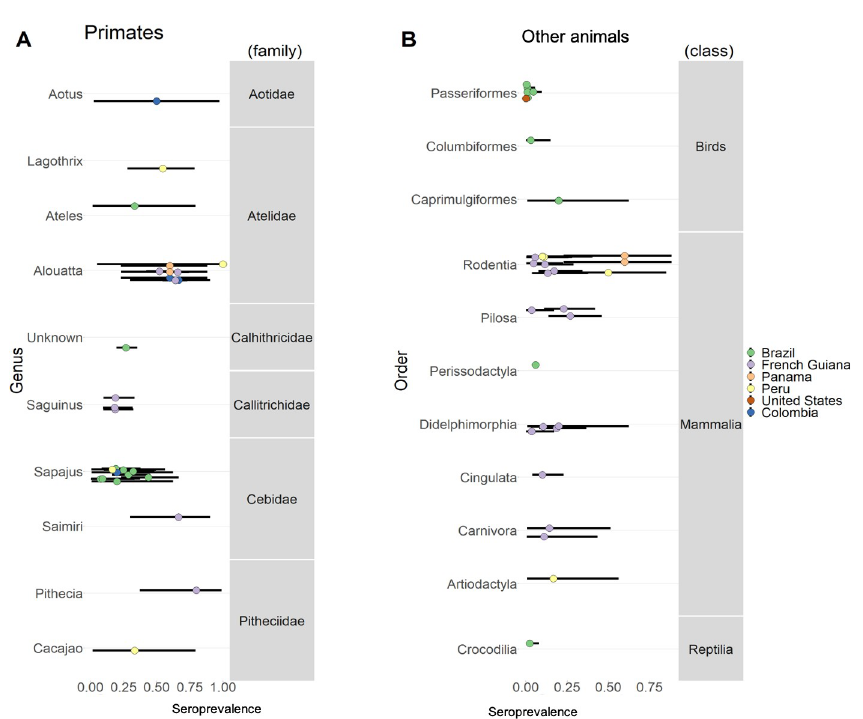
Fig 4. Proportion of animals that tested positive for MAYV antibodies across studies. A) Primates and their corresponding taxonomic family and genus. B) Other animals and their corresponding taxonomic class and order. Colours indicate study location. Points indicate the mean and lines represent the 95% confidence